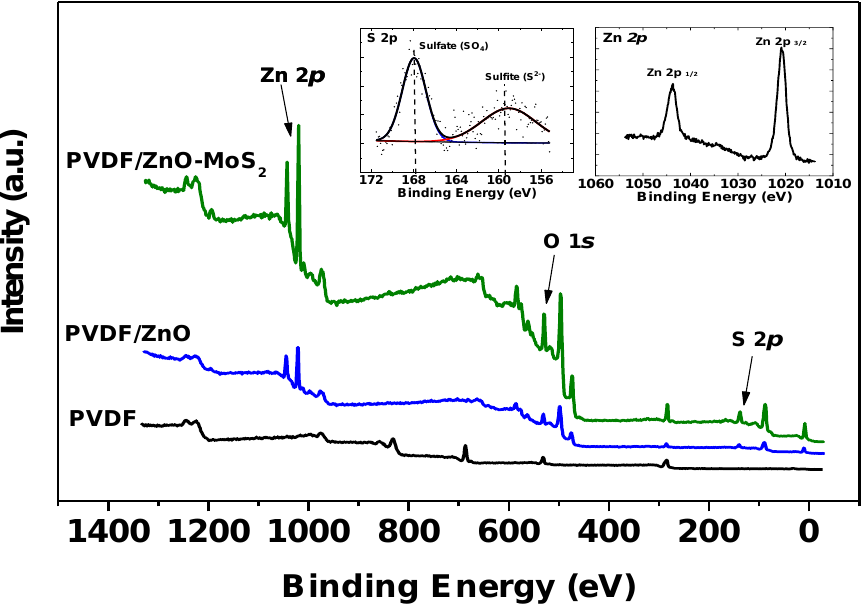
Figure 6. XPS binding energy spectrum of the virgin and the modified PVDF.